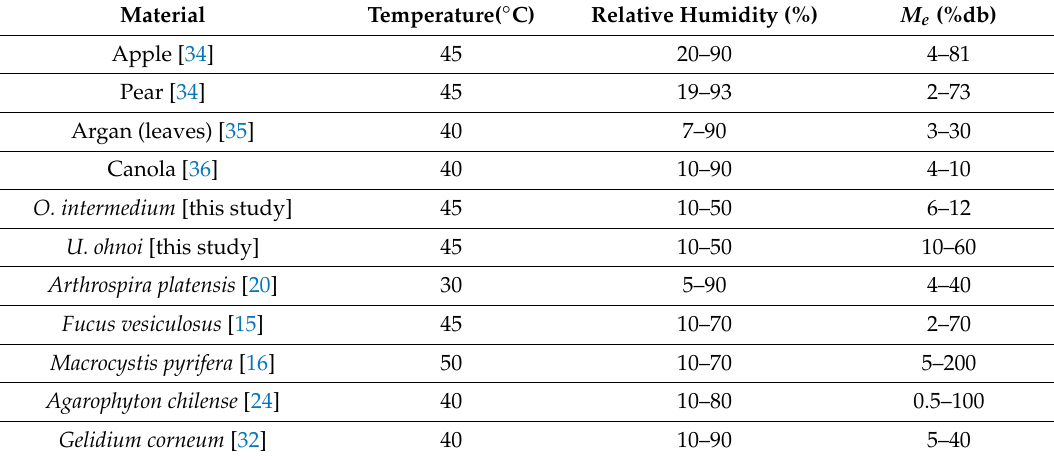
Table 2. Examples of equilibrium moisture contents for various biomaterials and